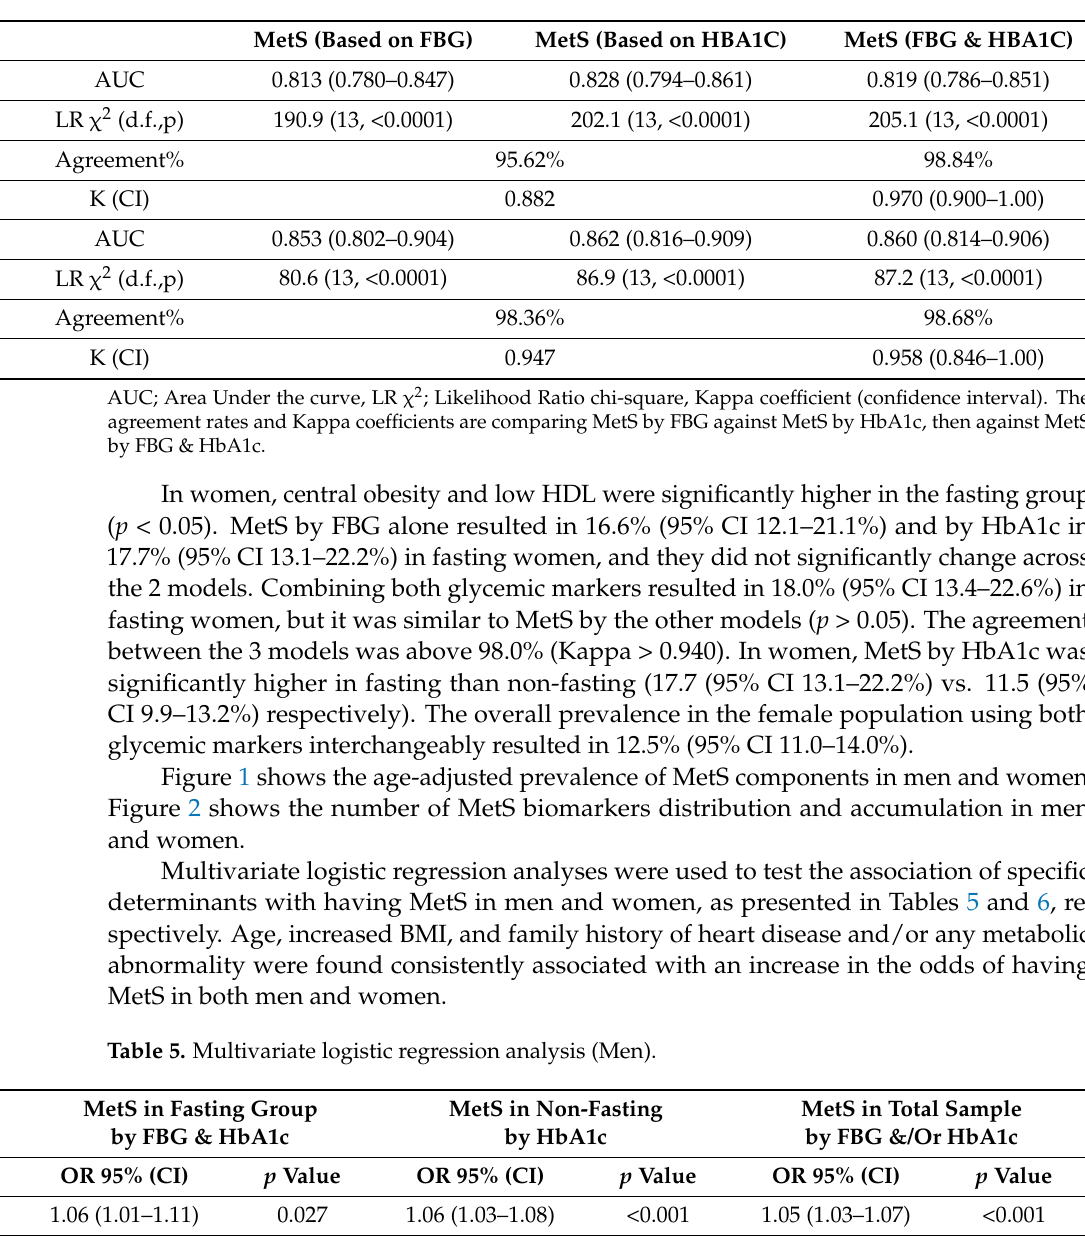
Table 4. The AUC and agreement rates of MetS using FBG, HbA1C, or both in the fasting sample.